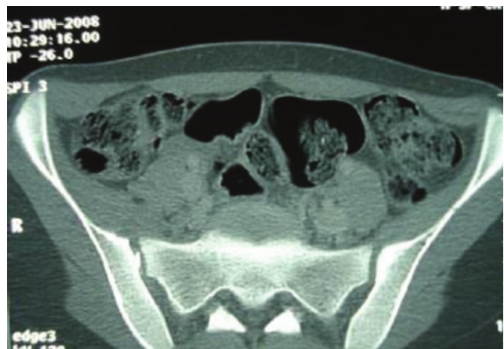
Figure 2: CT of the pelvis revealed apparent widening of the right sacroiliac joint with infiltration, edema of the soft tissue surrounding the joint, and presence of microabscess in the right iliacus muscle.